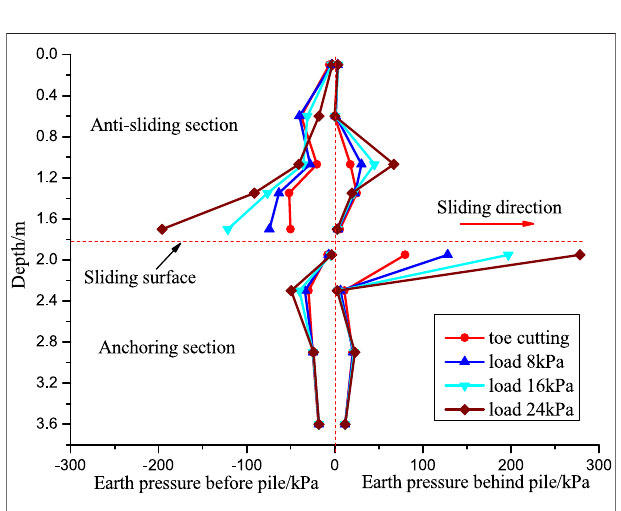
FIGURE 10 | Distribution of the earth pressure on pile